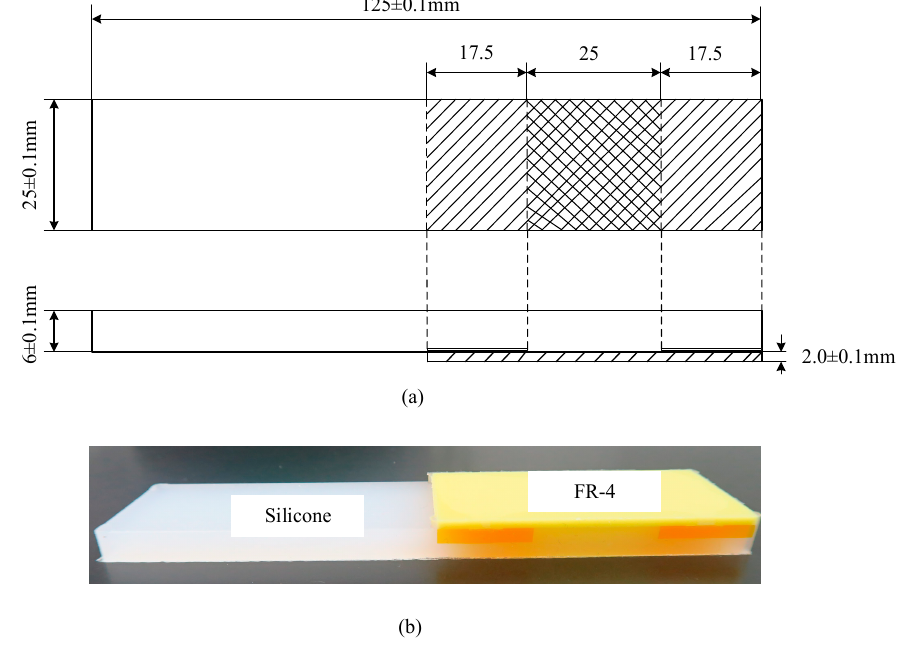
Figure 3. Interface bonding sample, ( a ) dimensional drawings of the peeled sample, ( b ) sample of interface